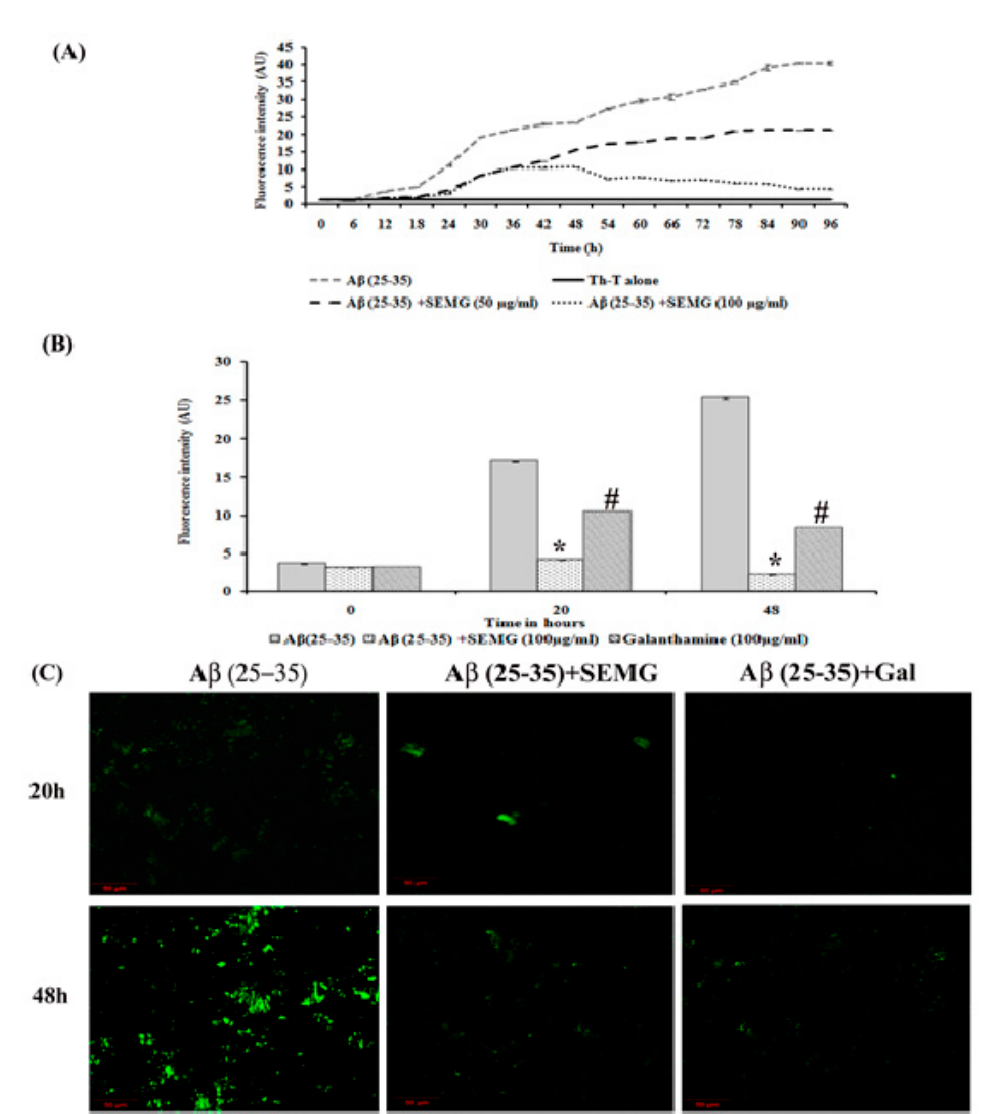
Figure 4. Anti-aggregation potential of SEMG against A β (25–35) preformed oligomers. ( A ) Sigmoidal curve representing aggregation kinetics of A β (25–35) from monomers to mature fibrils in the presence and absence of SEMG. ( B ) Th-T fluorescence assay. ( C ) Confocal microscopic analysis with 20 × magnification *,# p < 0.05 represents statistically significant difference in comparison with treated groups with control and positive control group.